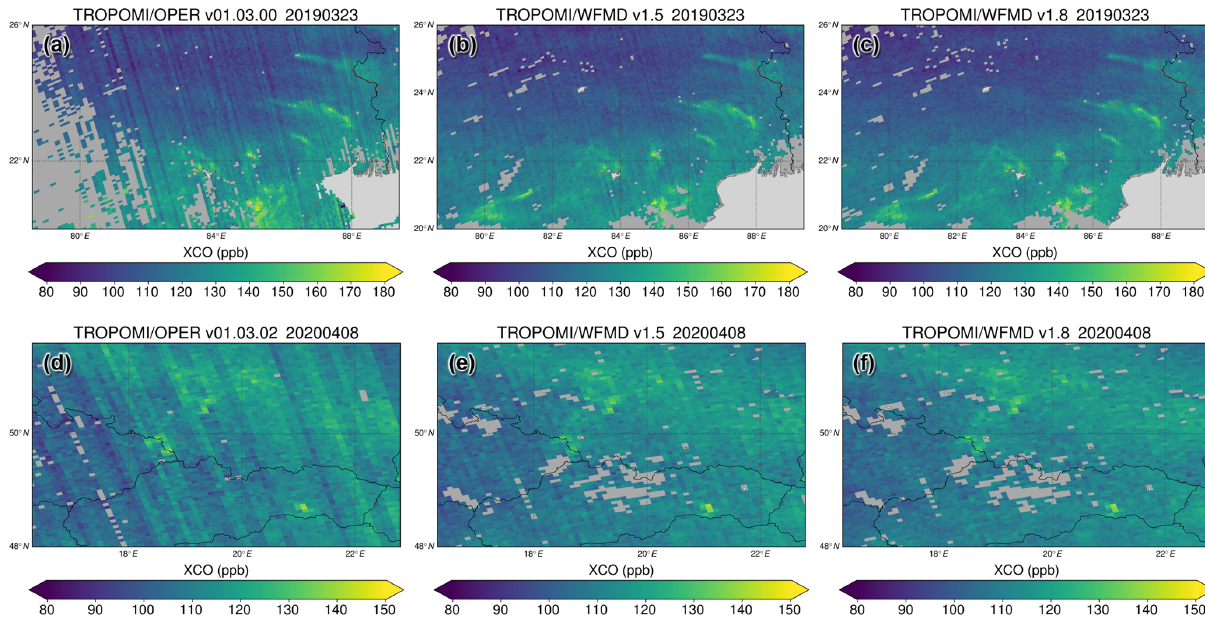
Figure 18. Performance of the destriping filter for the XCO product for two example scenes in India (a–c) and central Europe (d–f) with enhancements due to emissions from the steel industry. Panels (b) and (e) show the previous WFMD version, and panels (c) and (f) show the improved version with destriping. The operational product also exhibiting striping is shown in panels (a) and (d) for comparison.